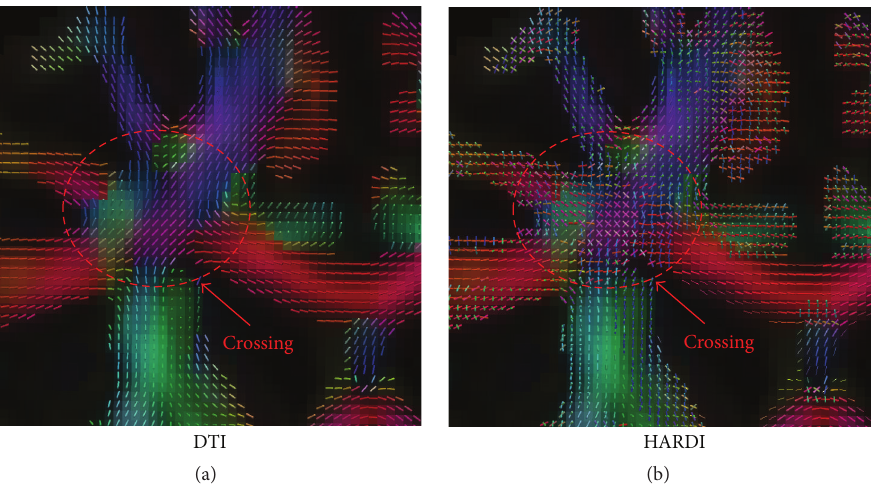
Figure 1: Directional glyphs at the intersection of the left corticospinal tract and the corpus callosum given by (a) the DTI method and (b) the HARDI